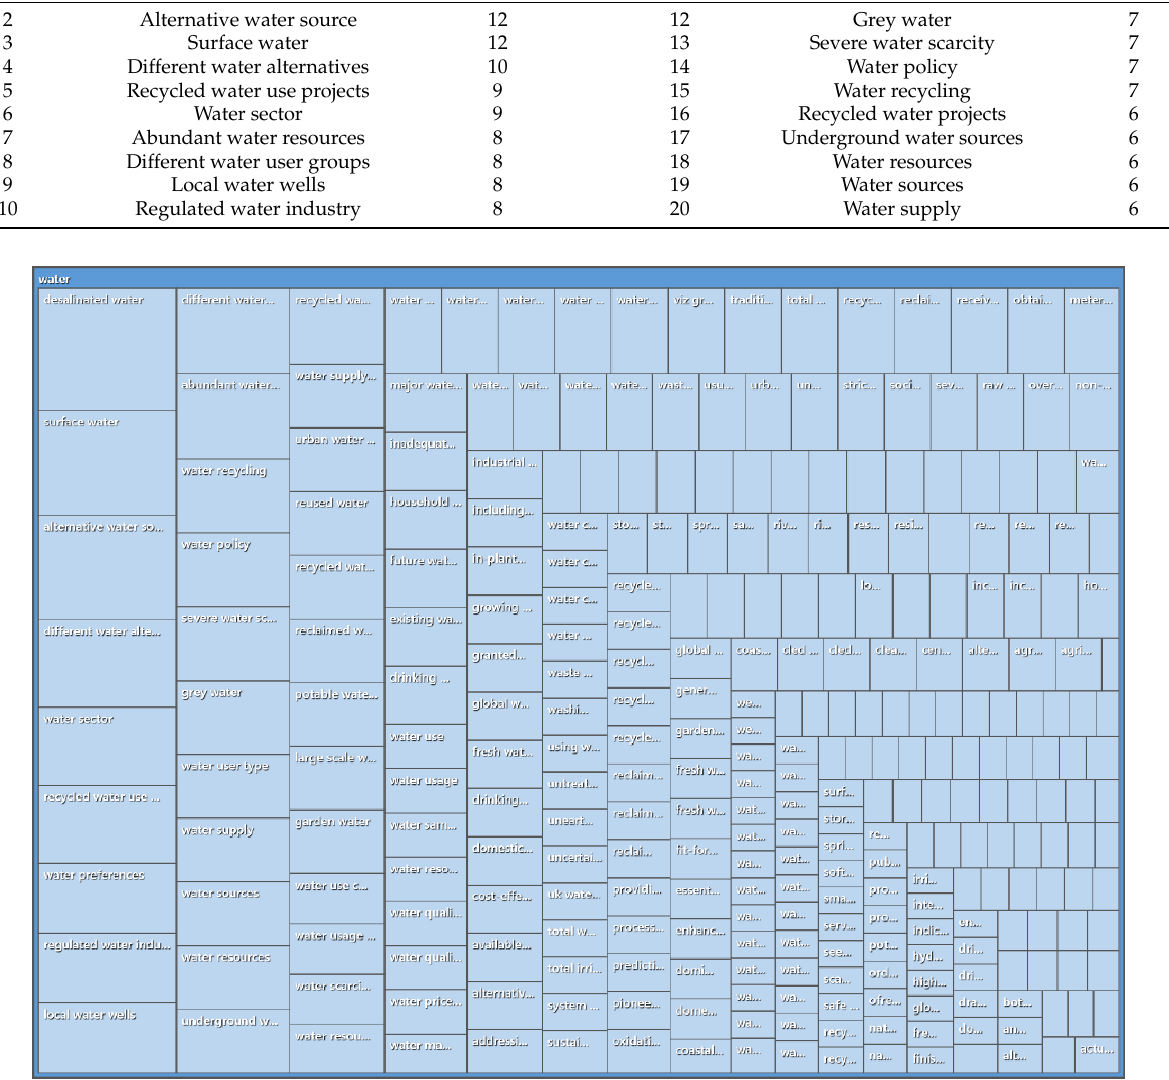
Figure 17. Hierarchical diagram of automatically encoded topic nodes and reference points from WOS.